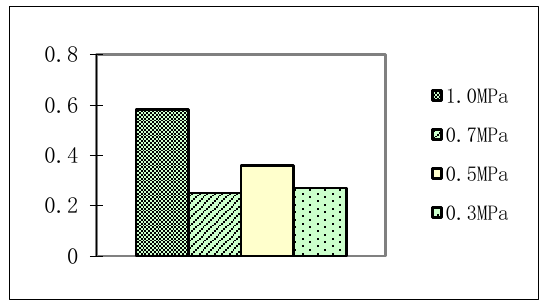
Figure 12. Comparison of δ / ∆ of walls with di ff erent axial compressive stresses.